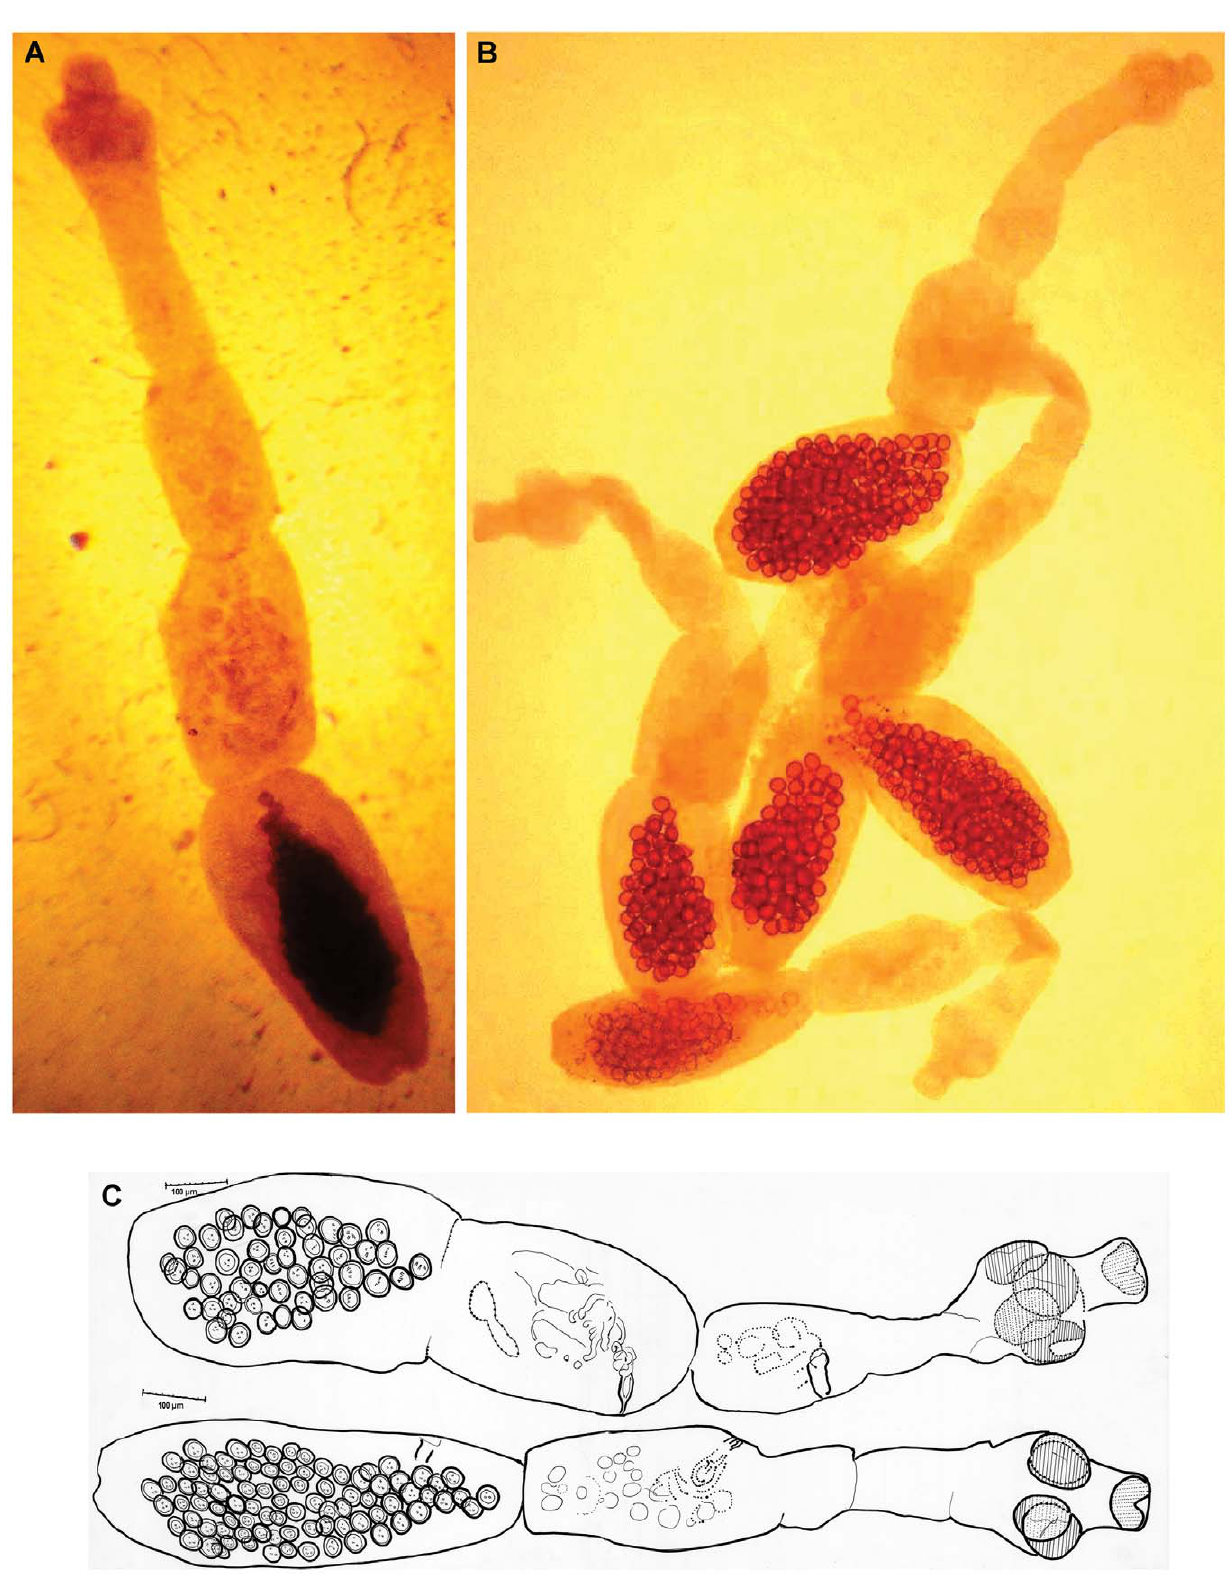
Figure 2. Echinococcusmultilocularis isolated from a jackal in Razavi Khorasan Province. A) in normal saline solution ( 6 100); B) with acetic acid alum carmine staining ( 6 40); C) Drawings of E. multilocularis ( 6 400) (made with the aid of Camera Lucida).